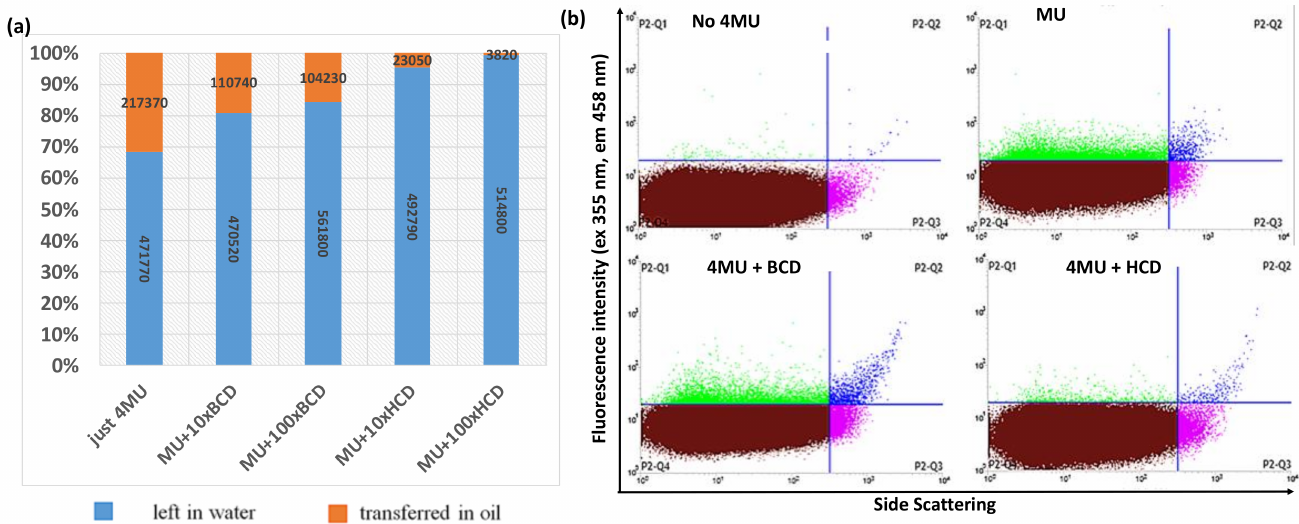
Figure 2. Analysis of cyclodextrins for the retention of 4-methylumbelliferone (4MU) in a simple biphasic mixture and single emulsions. ( a ) Partition coefficient of 4MU between the oil and water phases of a simple mixture, showing the relative fluorescent units (RFUs) measured in each phase. ( b ) FACS analysis of 4MU, 4MU+MCD, and 4MU+HCD in the external phase of single oil-in-water emulsions (ABIL EM-CMC-Triton